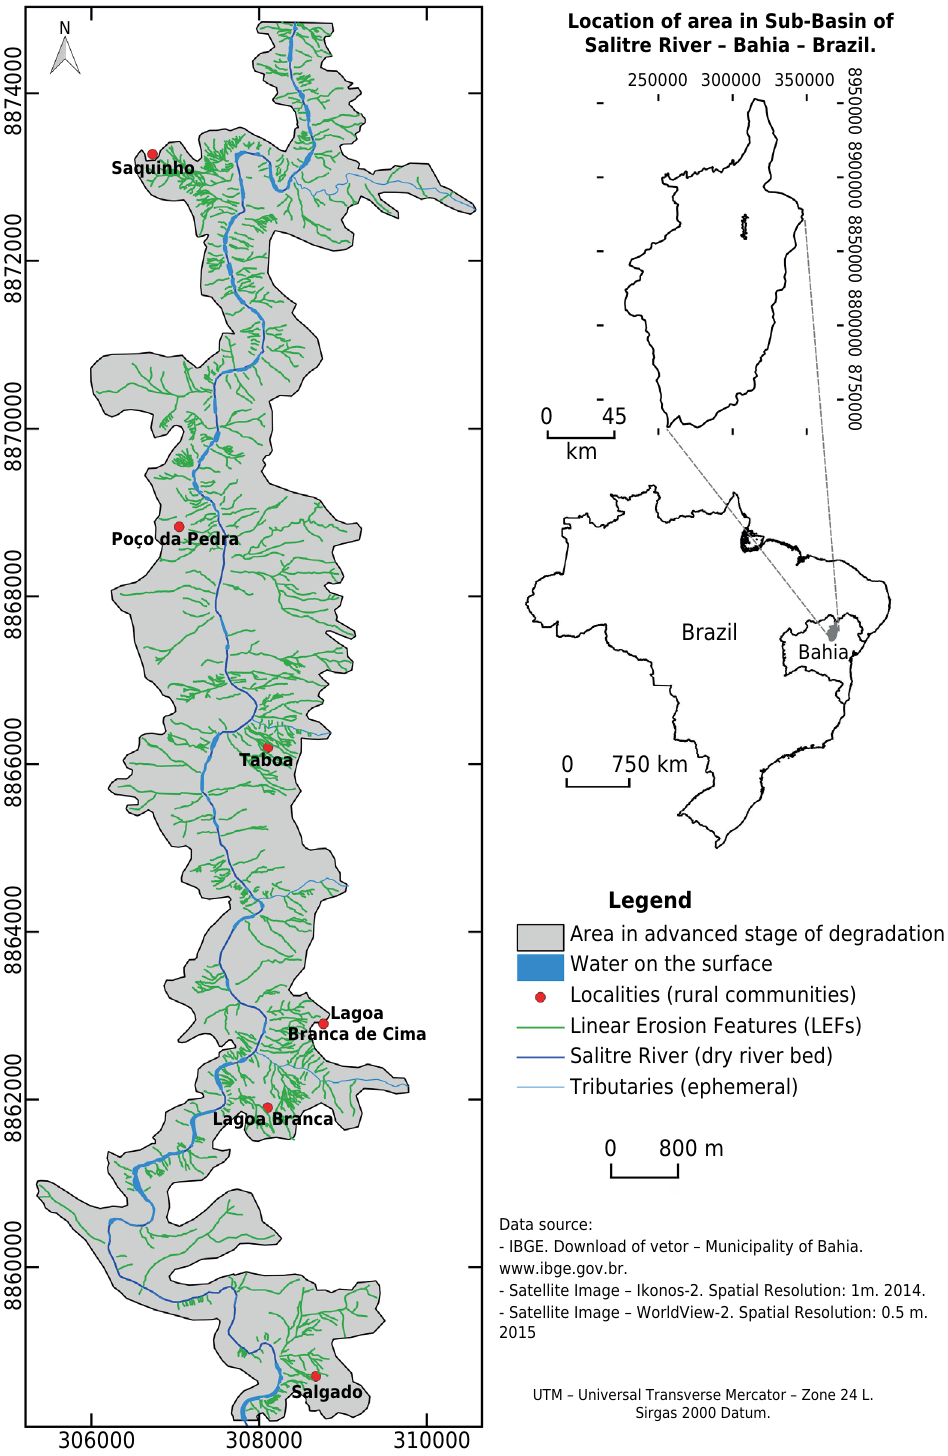
Figure 6. Map of Linear Erosive Features (LEFs) located in the middle course of the Salitre